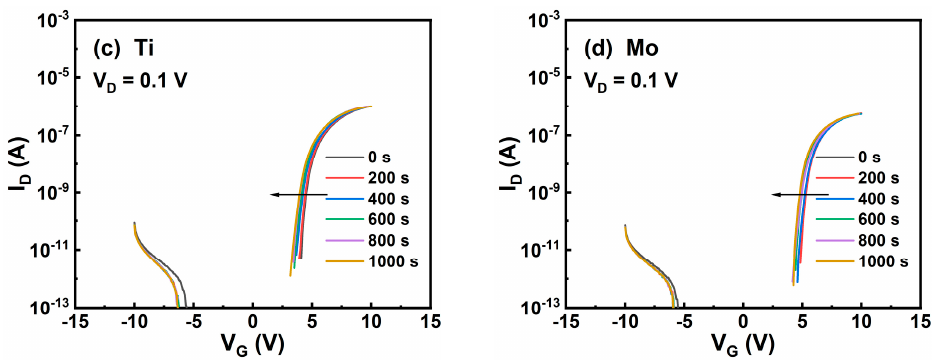
Figure 7. NBIS time-evolutions of the transfer curves for the ITO TFTs with ( a ) Al, ( b ) ITO, ( c ) Ti, and ( d ) Mo source/drain electrodes.